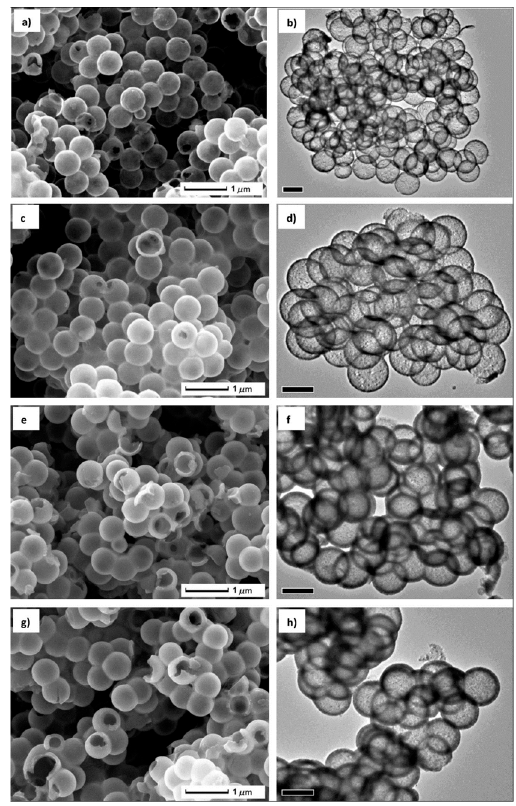
Figure 4. SEM and TEM images of the C-doped hollow TiO 2 spheres produced with different amounts of tetrabutyl orthotitanate: ( a , b ) 2 g; ( c , d ) 3 g; ( e , f ) 4 g; and ( g , h ) 5 g. From Ref. [45]. Reprinted with permission from Elsevier.